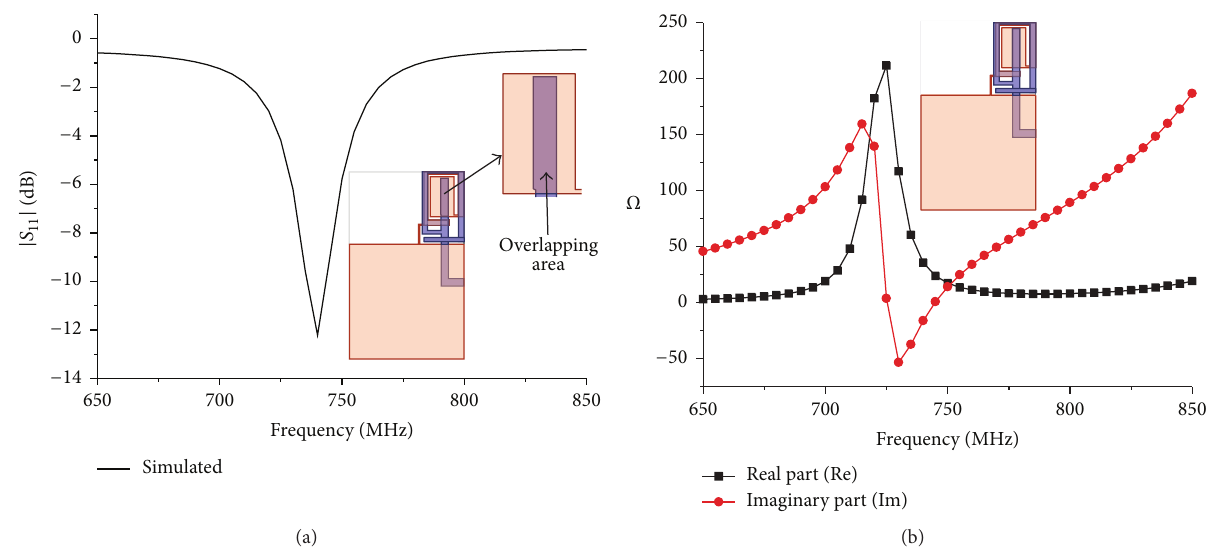
Figure 3: Antenna performance of the monopole antenna with improved ground plane: (a) |𝑆 11 | curve. (b) Input impedance.